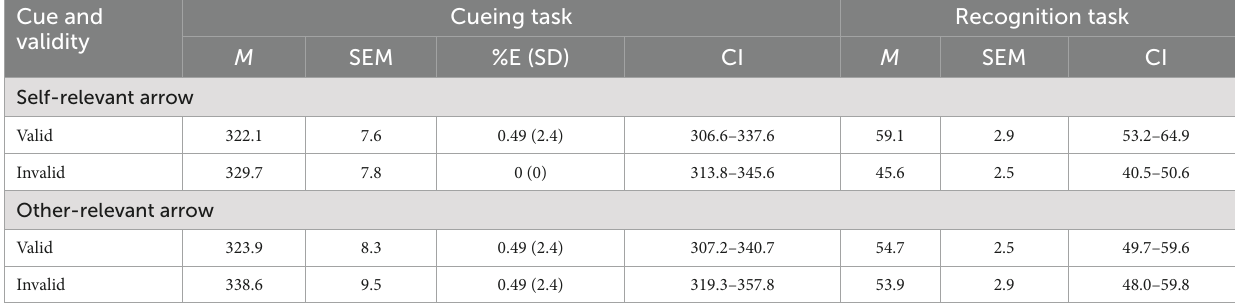
TABLE 1 Mean response times (ms) in the cueing task and mean accuracy (%) in the recognition task as a function of cue and validity in Experiment 1. Cue and